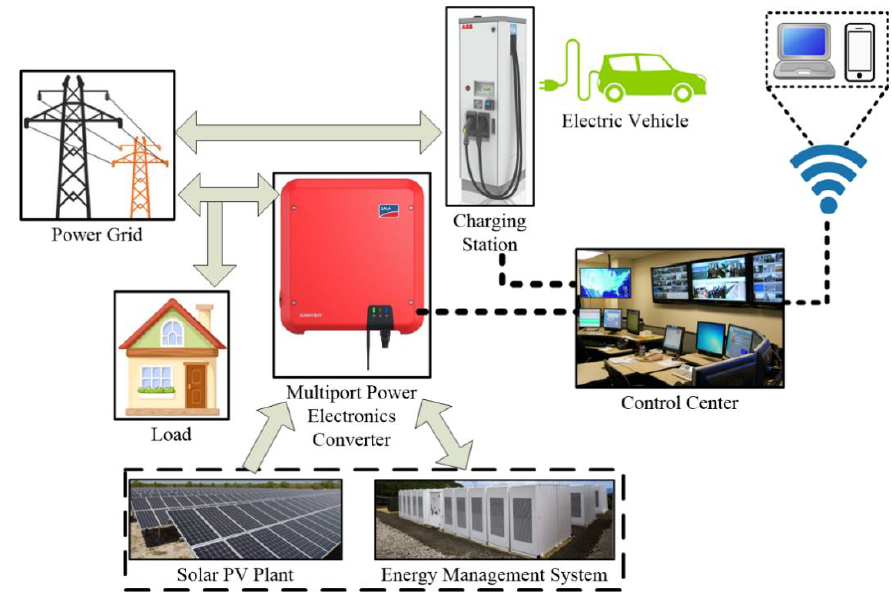
Figure 1. An overview of the proposed hybrid system.